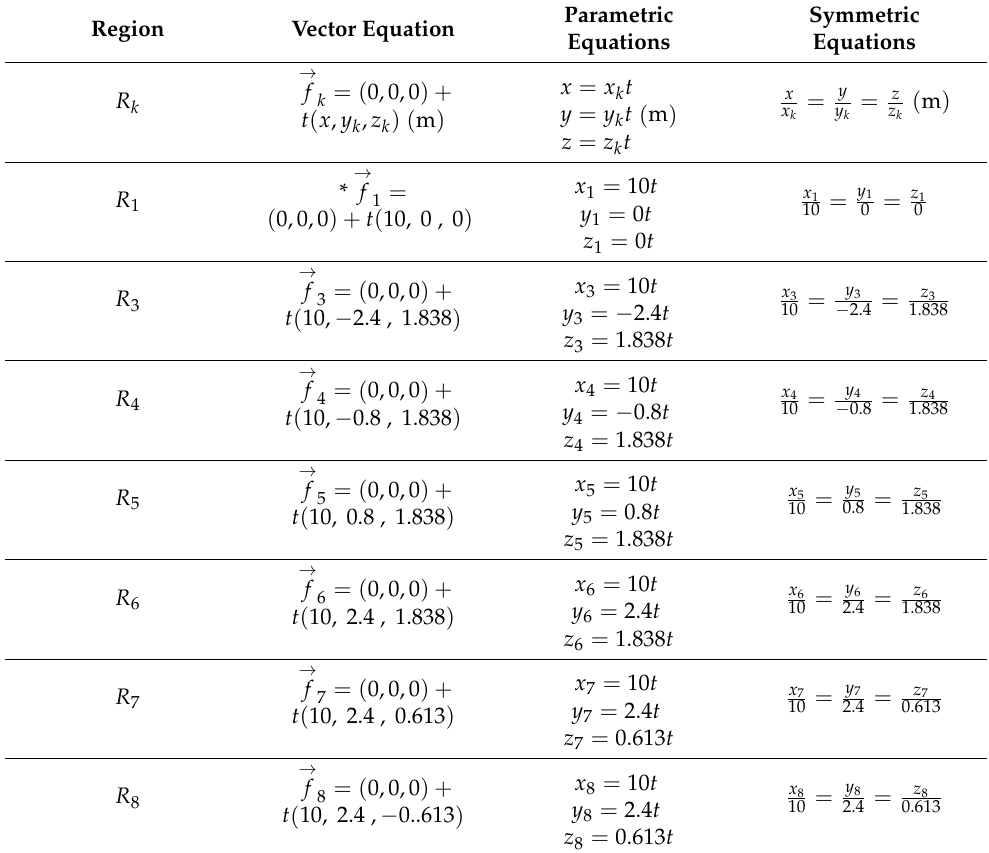
Figure 8. Second experiment. ( a ) Frame used during the second experiment: objects located in regions 𝑅 2 , 𝑅 9−13 . Such regions are identified in red and collision − free regions 𝑅 1 , 𝑅 3−8 are marked with a blue color; ( b ) graphical representation of vector reference 𝒇⃗ 𝟏 : the reference starts from the drone and its endpoint is the central coordinates of the region 𝑅 1 . Table 4. Collision-free trajectories generated by the TGBOA algorithm using the frame shown in Figure 8a. Parametric Region Vector Equation Equations